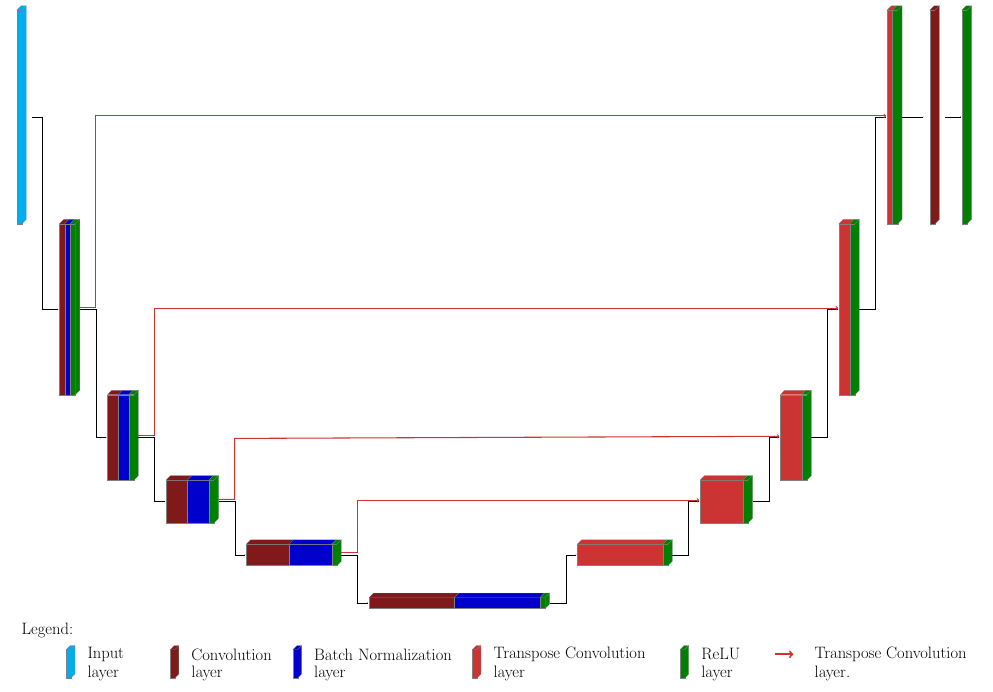
Figure 2. The Proposed upU-net architecture. The contracting path consists in several blocks, 5 in the example provided in the Figure. Each block is composed by convolution layer (dark red), batch normalization layer (dark blue) and a Rectified Linear Unit (ReLU) layer (green). The expansive path’s blocks have just two parts: up-convolution layer (light red) and a ReLu layer. All the features of the last block are merged via a 1d1 convolution layer, followed by a further ReLu. The red lines are connecting the outputs of each block from the contracting path with the block of the expansive path of higher dimension: this seems to induce a smoother behavior of the